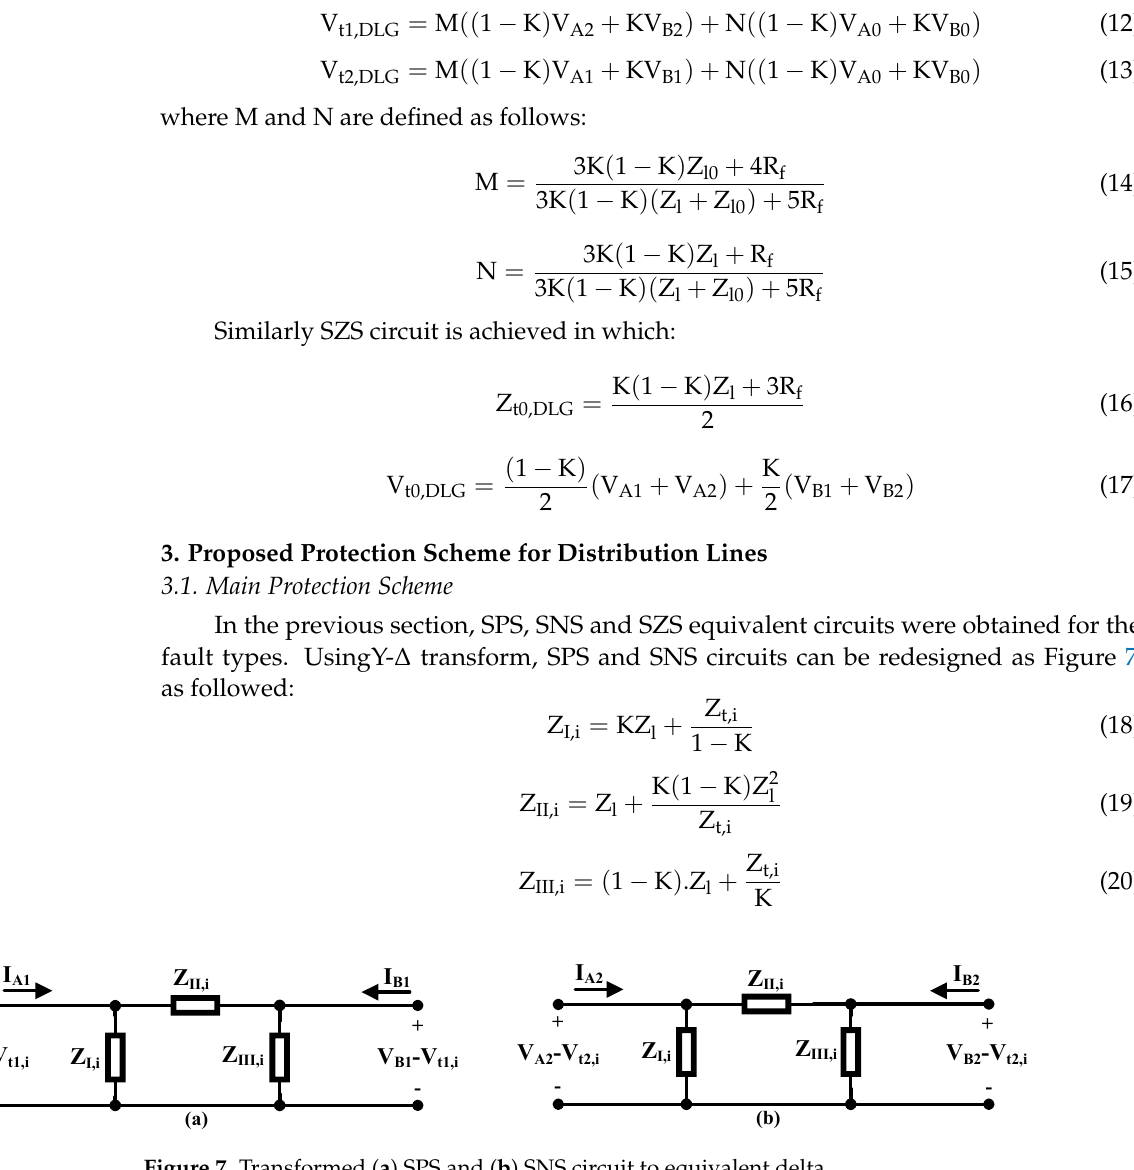
Figure 8. R f -Z I,LL curve for several fault location. Figure 9. R f -Z II,LL curve for several fault location. These facts are true for other fault types. The proposed fault detection scheme is based on high reduction in Z I,i during the fault, compared to normal conditions. By applying KCL and KVL in SZS and Figure 7 circuits, (21)–(23) are obtained. In these equations V t1,i , V t2,i and V t0,i are functions of K, R f , the sequence voltages in the line ends and the sequence line impedances. Moreover, K and R f are substituted by Z I,i and